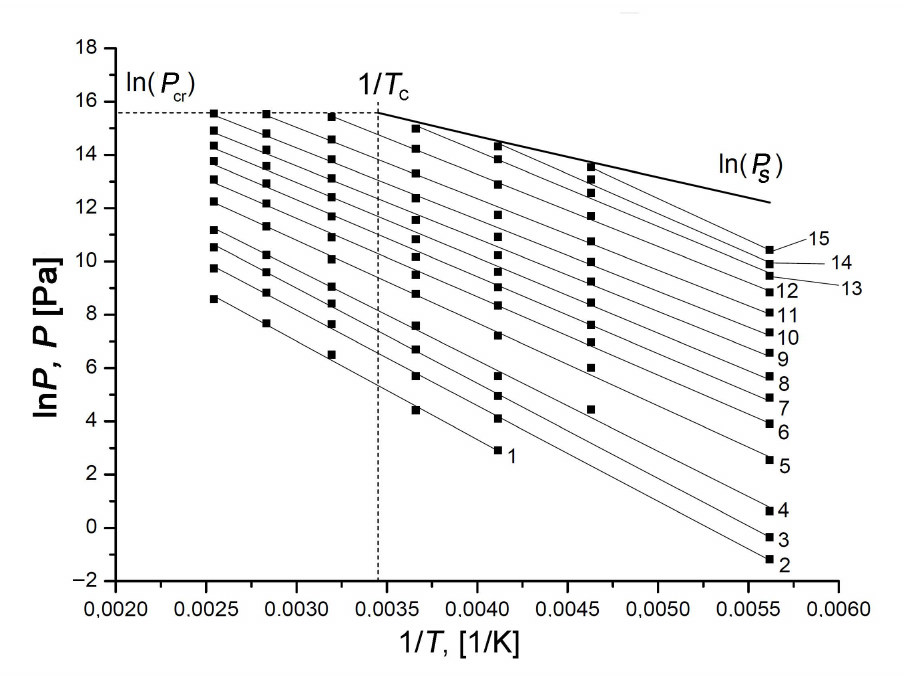
Figure 9. The isosteres of Xe adsorption in SiC-AC at the Xe adsorption values, a , mmol/g: 0.1 (1); 0.3 (2); 0.6 (3); 1.0 (4); 2.0 (5); 3.0 (6); 4.0 (7); 5.0 (8); 6.0 (9); 7.0 (10); 8.0 (11); 9.0 (12); 9.8 (13); 10.3 (14); and 10.8 (15). The experimental data (symbols) are approximated by the linear functions (solid straight lines). The bold line shows ln P s , where P s is the saturated vapor pressure; the dashed lines correspond to the critical pressure and temperature of